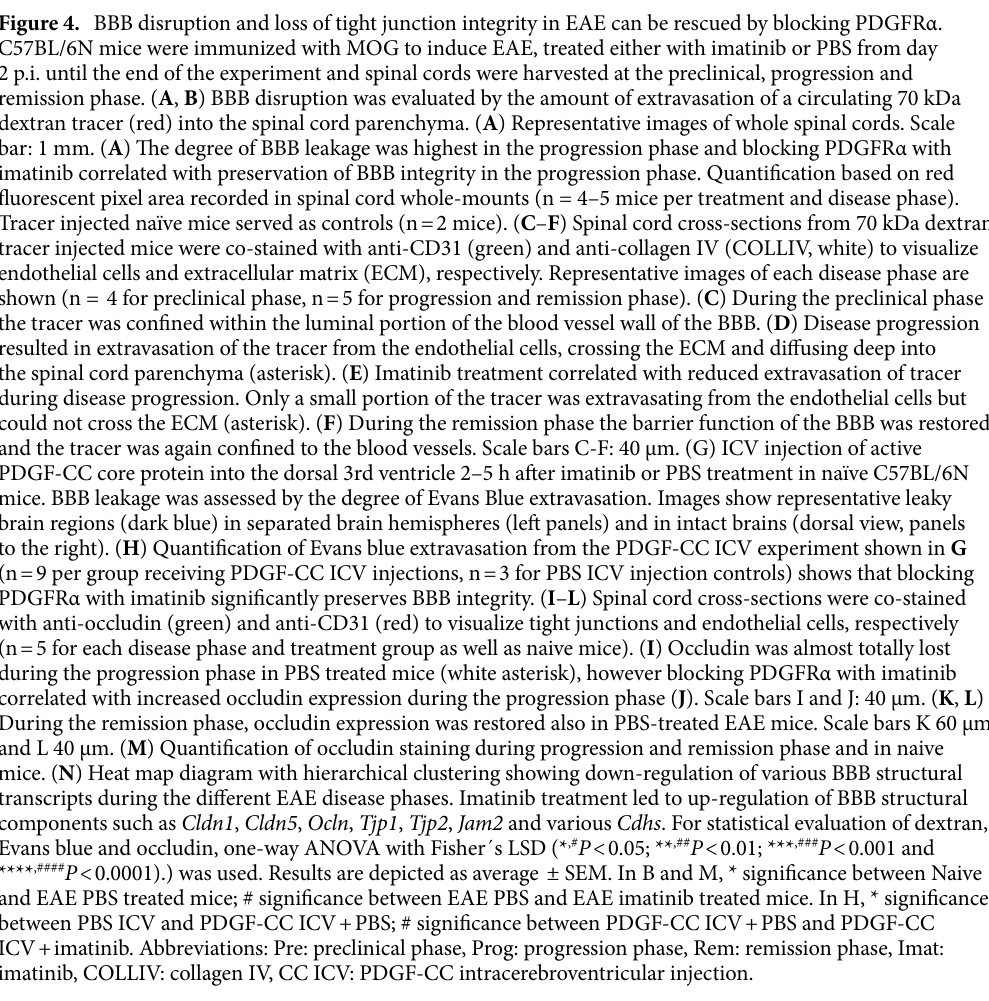
Figure 4. BBB disruption and loss of tight junction integrity in EAE can be rescued by blocking PDGFRα. C57BL/6N mice were immunized with MOG to induce EAE, treated either with imatinib or PBS from day 2 p.i. until the end of the experiment and spinal cords were harvested at the preclinical, progression and remission phase. ( A , B ) BBB disruption was evaluated by the amount of extravasation of a circulating 70 kDa dextran tracer (red) into the spinal cord parenchyma. ( A ) Representative images of whole spinal cords. Scale bar: 1 mm. ( A ) The degree of BBB leakage was highest in the progression phase and blocking PDGFRα with imatinib correlated with preservation of BBB integrity in the progression phase. Quantification based on red fluorescent pixel area recorded in spinal cord whole-mounts (n = 4–5 mice per treatment and disease phase). Tracer injected naïve mice served as controls (n = 2 mice). ( C – F ) Spinal cord cross-sections from 70 kDa dextran tracer injected mice were co-stained with anti-CD31 (green) and anti-collagen IV (COLLIV, white) to visualize endothelial cells and extracellular matrix (ECM), respectively. Representative images of each disease phase are shown (n = 4 for preclinical phase, n = 5 for progression and remission phase). ( C ) During the preclinical phase the tracer was confined within the luminal portion of the blood vessel wall of the BBB. ( D ) Disease progression resulted in extravasation of the tracer from the endothelial cells, crossing the ECM and diffusing deep into the spinal cord parenchyma (asterisk). ( E ) Imatinib treatment correlated with reduced extravasation of tracer during disease progression. Only a small portion of the tracer was extravasating from the endothelial cells but could not cross the ECM (asterisk). ( F ) During the remission phase the barrier function of the BBB was restored and the tracer was again confined to the blood vessels. Scale bars C-F: 40 µm. (G) ICV injection of active PDGF-CC core protein into the dorsal 3rd ventricle 2–5 h after imatinib or PBS treatment in naïve C57BL/6N mice. BBB leakage was assessed by the degree of Evans Blue extravasation. Images show representative leaky brain regions (dark blue) in separated brain hemispheres (left panels) and in intact brains (dorsal view, panels to the right). ( H ) Quantification of Evans blue extravasation from the PDGF-CC ICV experiment shown in G (n = 9 per group receiving PDGF-CC ICV injections, n = 3 for PBS ICV injection controls) shows that blocking PDGFRα with imatinib significantly preserves BBB integrity. ( I – L ) Spinal cord cross-sections were co-stained with anti-occludin (green) and anti-CD31 (red) to visualize tight junctions and endothelial cells, respectively (n = 5 for each disease phase and treatment group as well as naive mice). ( I ) Occludin was almost totally lost during the progression phase in PBS treated mice (white asterisk), however blocking PDGFRα with imatinib correlated with increased occludin expression during the progression phase ( J ). Scale bars I and J: 40 µm. ( K , L ) During the remission phase, occludin expression was restored also in PBS-treated EAE mice. Scale bars K 60 µm and L 40 µm. ( M ) Quantification of occludin staining during progression and remission phase and in naive mice. ( N ) Heat map diagram with hierarchical clustering showing down-regulation of various BBB structural transcripts during the different EAE disease phases. Imatinib treatment led to up-regulation of BBB structural components such as Cldn1 , Cldn5 , Ocln , Tjp1 , Tjp2 , Jam2 and various Cdhs . For statistical evaluation of dextran, Evans blue and occludin, one-way ANOVA with Fisher´s LSD (* ,# P < 0.05; ** ,## P < 0.01; *** ,### P < 0.001 and **** ,#### P < 0.0001).) was used. Results are depicted as average ± SEM. In B and M, * significance between Naive and EAE PBS treated mice; # significance between EAE PBS and EAE imatinib treated mice. In H, * significance between PBS ICV and PDGF-CC ICV + PBS; # significance between PDGF-CC ICV + PBS and